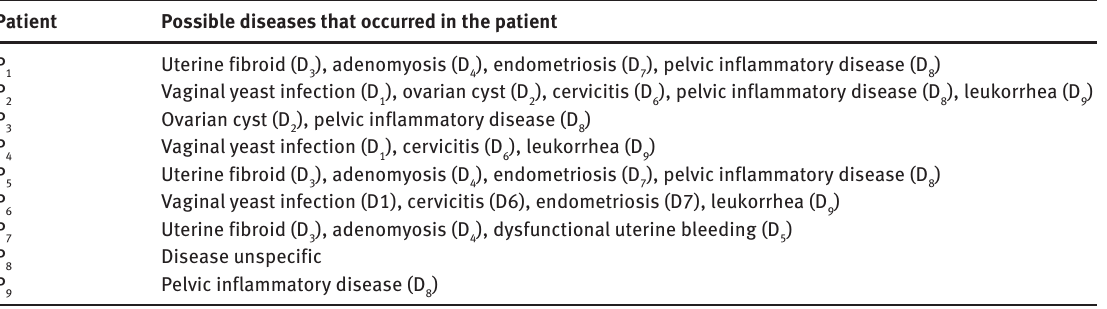
Table 6: Possibility of Diseases Occurring for a Patient (Case Study Example).